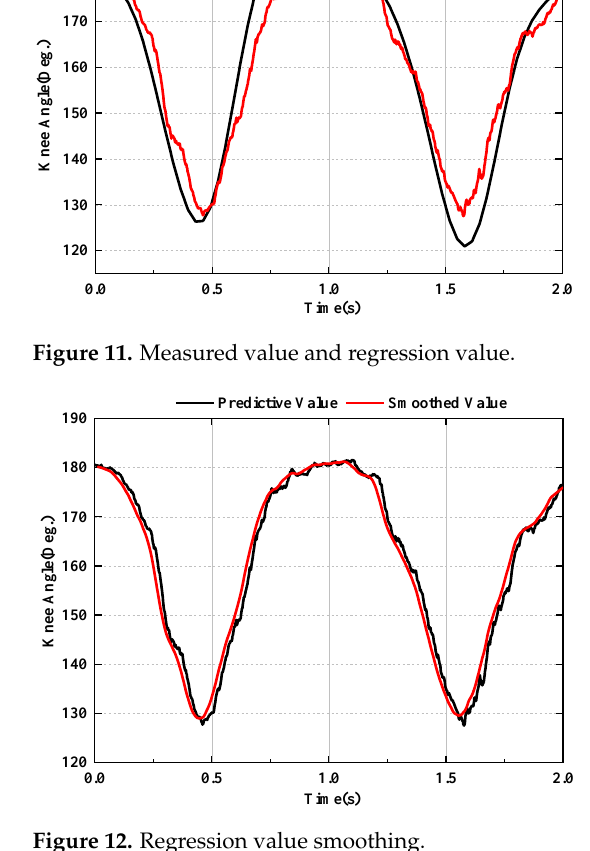
Figure 12. Regression value smoothing.